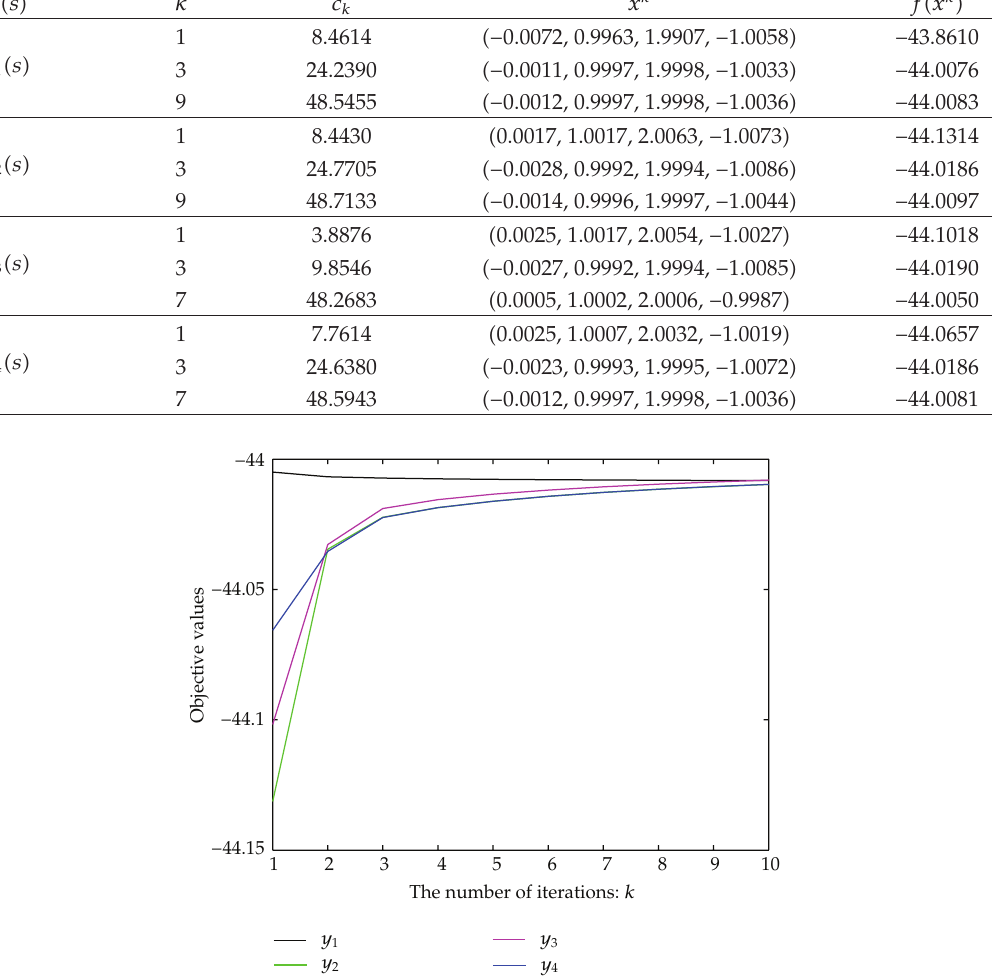
Figure 2: Result of Example